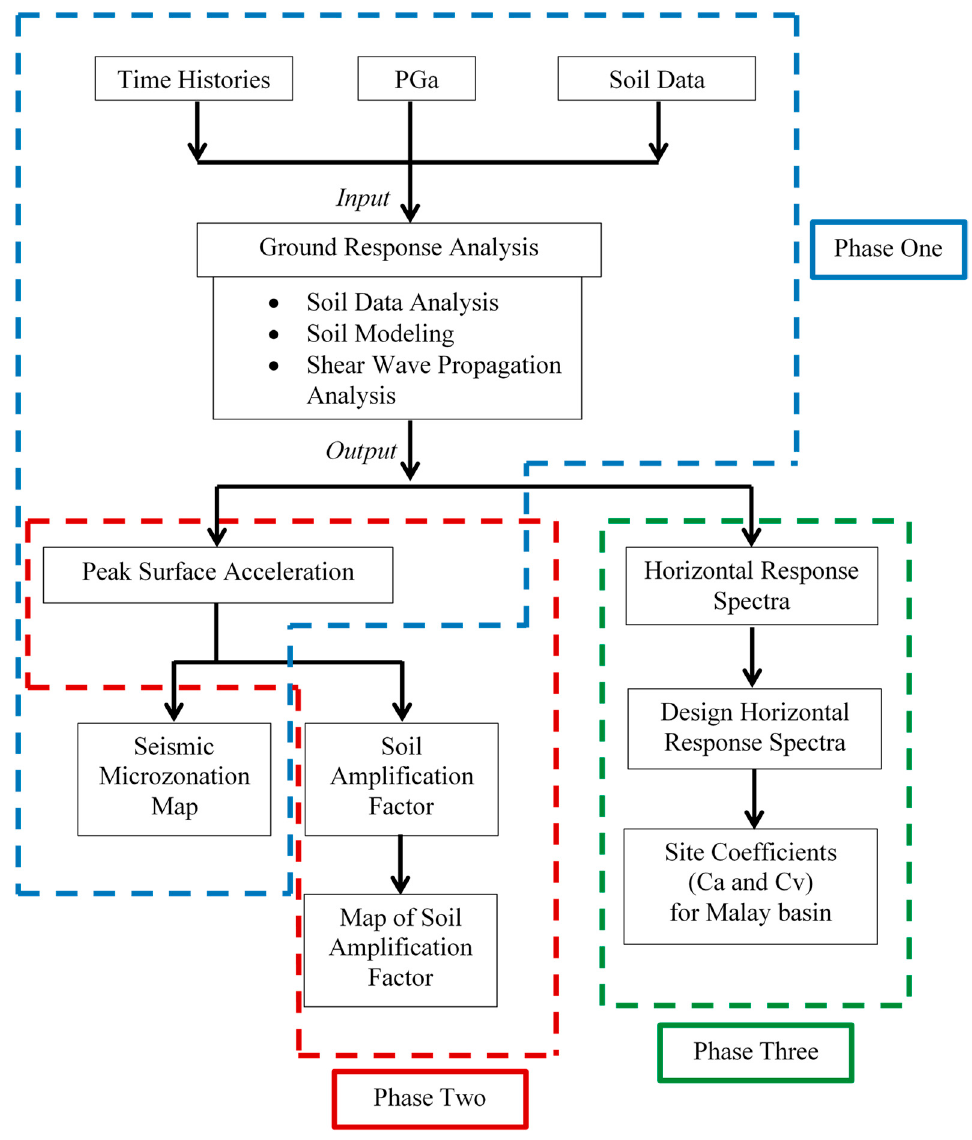
Figure 4. Flowchart of research methodology.